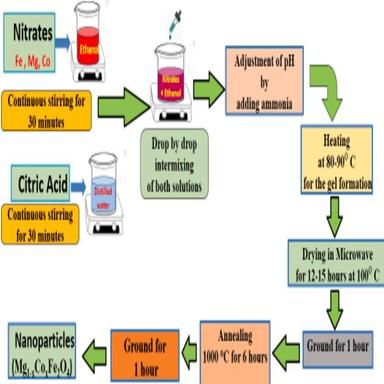
The Schematic diagram of Sol-gel method for preparation of Mg1-xCoxFe2O4 with (x = 0, 0.03, 0.06, and 0.09) nanoparticles.